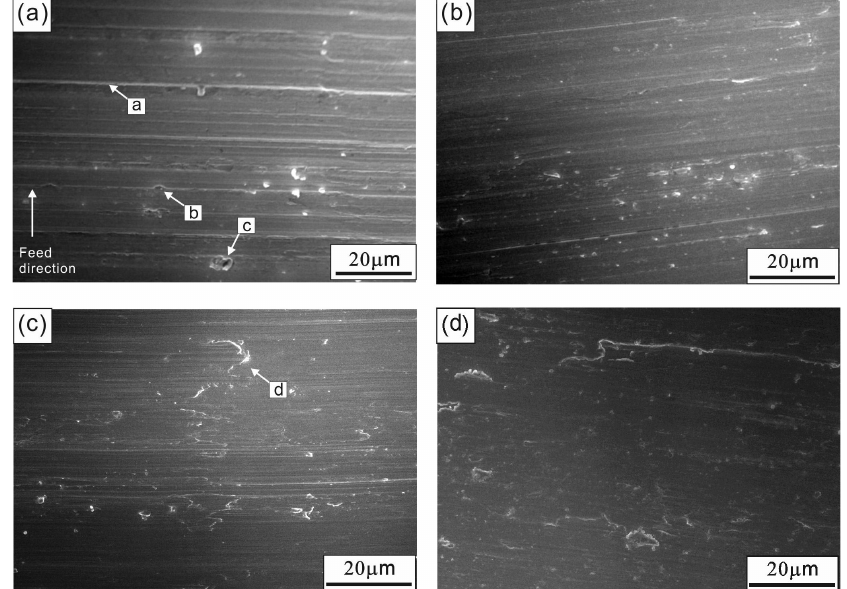
Figure 8. Cut surfaces of Ti15Sn x Cu samples: (a) AS Ti15Sn, (b) HT Ti15Sn, (c) AS Ti15Sn2Cu and (d) HT Ti15Sn2Cu.